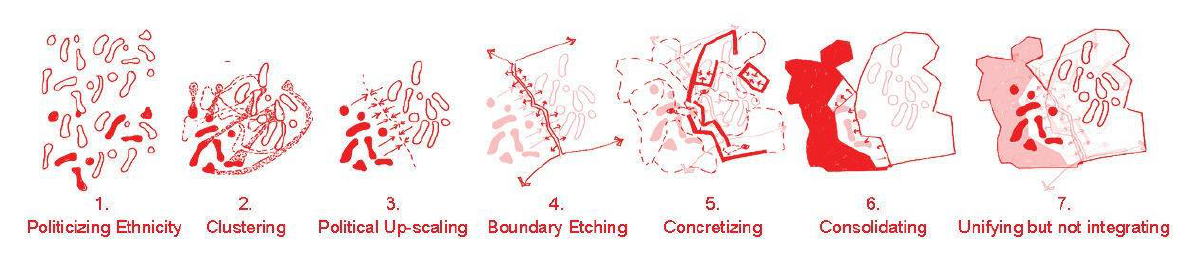
Figure 2. Segregated spatial patterns and scenarios of change over